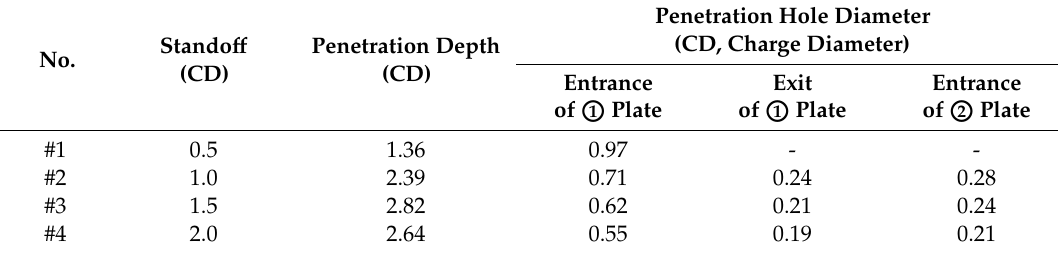
Table 1. Experimental results of high-density reactive jets penetrating steel